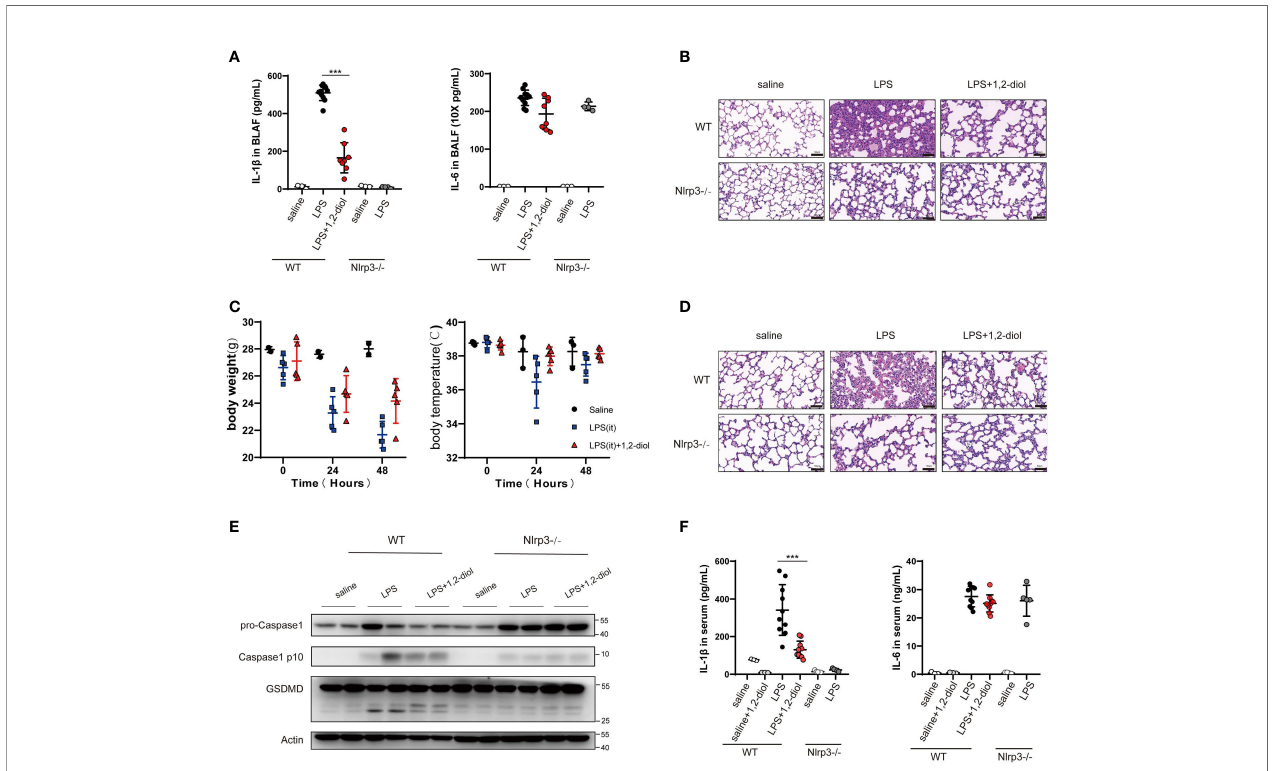
FIGURE 5 | 1,2-Diol inhibits NLRP3 activation in vivo and has bene fi cial effects in mouse models of LPS induce ALI. (A) IL-1 b and IL-6 release in the BLAF were measured by ELISA. WT or Nlrp3 − / − mice were pretreated with 40 mg/kg, 12-diol by intraperitoneal injection 30 min before i.t. instilled with 15 mg/kg LPS. (B) H&E staining show representative images of lung in WT or Nlrp3 − / − mice which i.t. instilled with 15 mg/kg LPS (scale bar, 50 m m). (C) The body weight and the body temperature were recorded during ALI. 1,2-diol treatment has a tendency to reduce the loss of body temperature and body weight. (D) H&E staining showed representative images of lung in WT or Nlrp3 − / − mice which was intraperitoneal challenged with LPS 25 mg/kg (scale bar, 50 m m). (E) Western blots for the cleavage of GSDMD and the expression of Caspase-1 in lung. WT or Nlrp3 − / − mice were pretreated with 40 mg/kg 1,2-diol by intraperitoneal injection 30min before intraperitoneally challenged with LPS 25 mg/kg. (F) IL-1 b and IL-6 released in the serum were measured by ELISA. WT or Nlrp3 − / − mice were pretreated with 40 mg/kg 1,2-diol by intraperitoneal injection 30 min before intraperitoneally challenged with LPS 25 mg/kg. (***p <0.001).